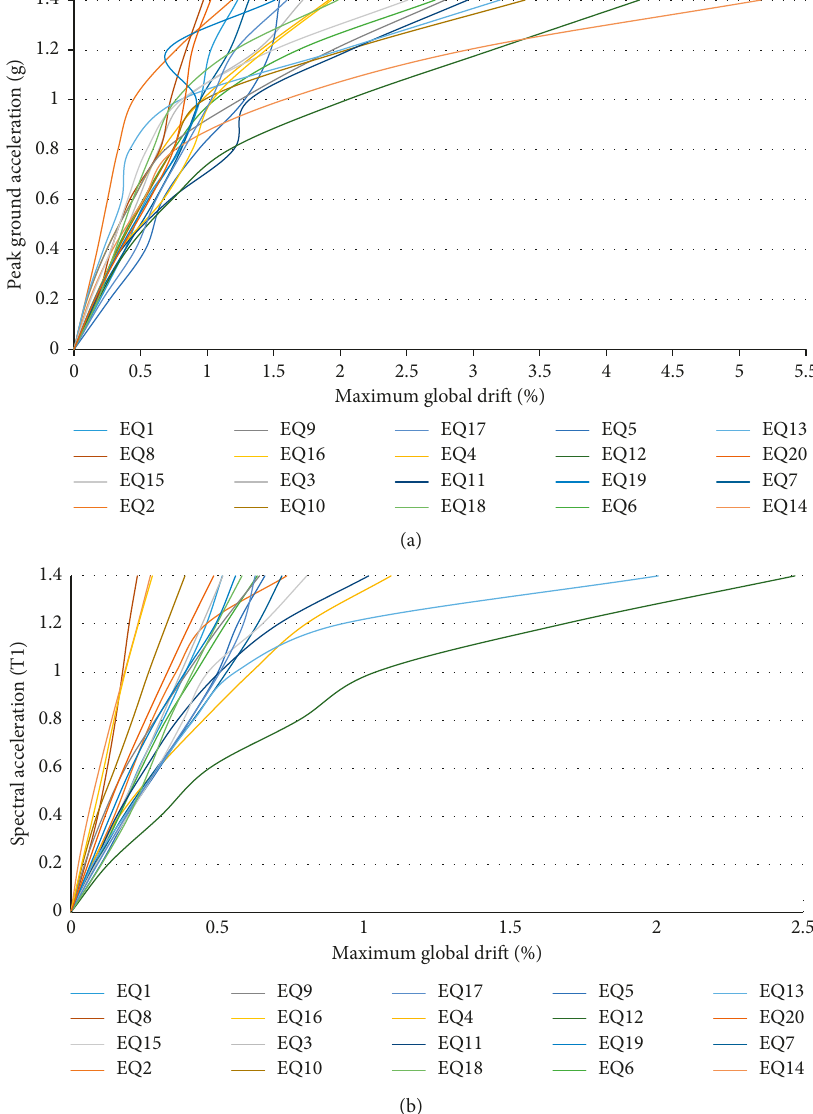
a (T1) v/s global drift in